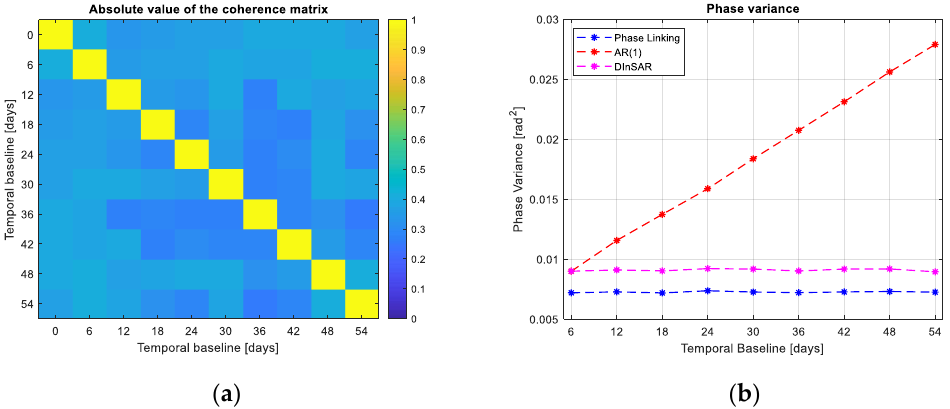
Figure 3. Variance of the phase estimates in different scenarios. ( a ) coherence matrix of a Permanent Scatterer. showing coherence equal to 0.6 for all the images. ( b ) phase variance using different estimators in the PS case.